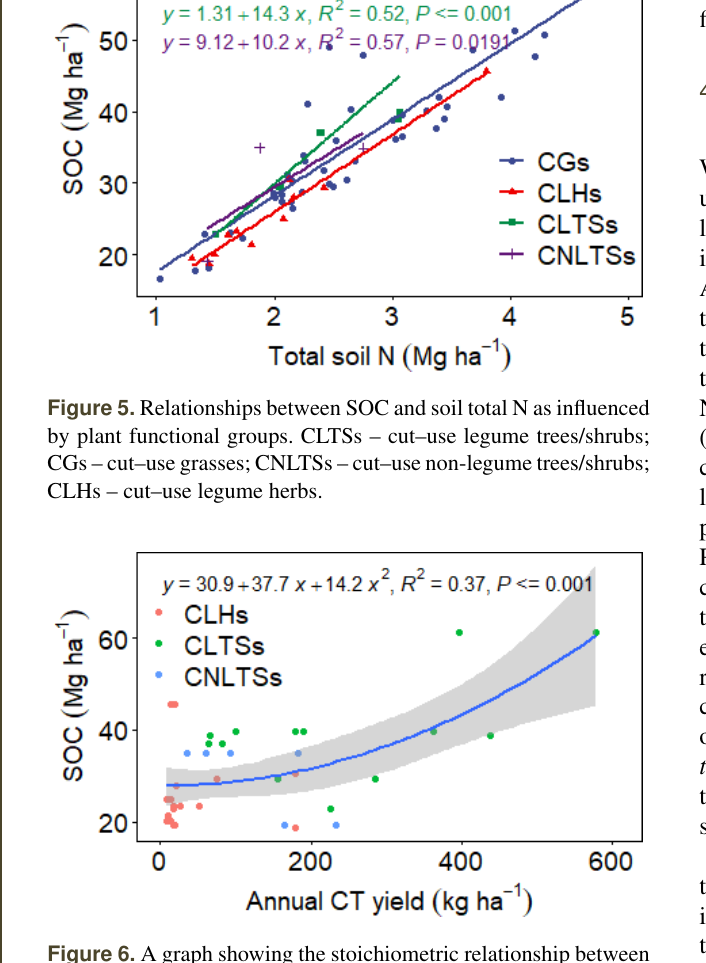
Figure 6. A graph showing the stoichiometric relationship between SOC and leaf biomass CT. The grey band shows the 95% confi- dence interval. CLTSs – cut–use legume trees/shrubs; CNLTSs – cut–use non-legume trees/shrubs; CLHs – cut–use legume